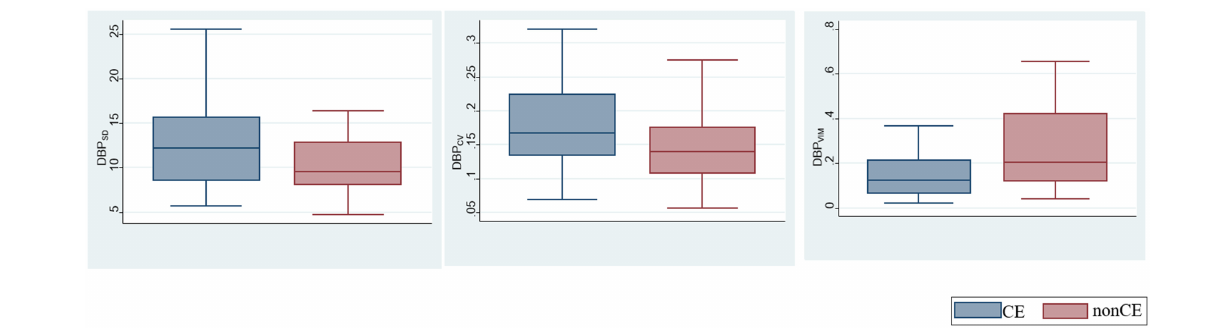
in patients with poor outcomes than in those with good outcomes after ERT. However, no significant differences were observed in based on functional outcomes ( Table 3 ).